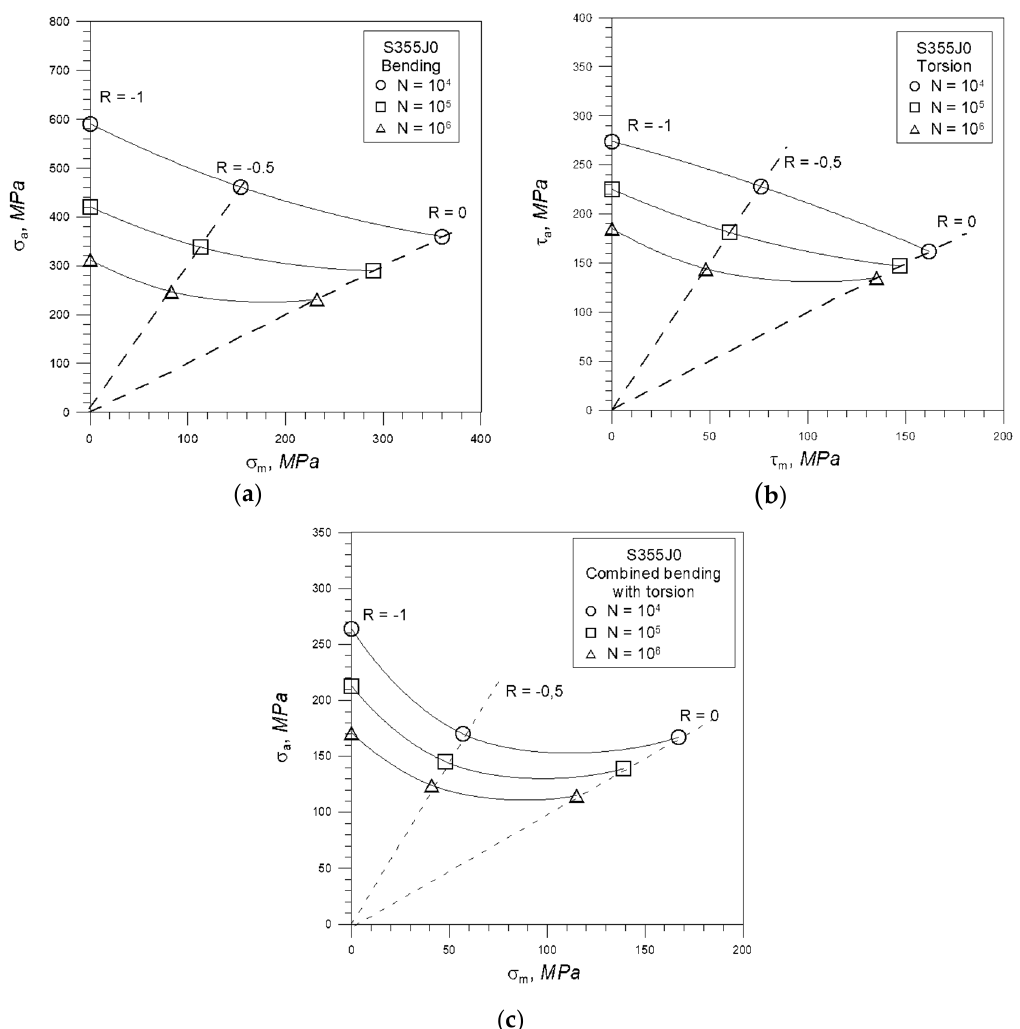
Figure 5. The dependence of the stress amplitude on the mean stress for: ( a ) bending, ( b ) torsion, ( c ) bending with torsion.